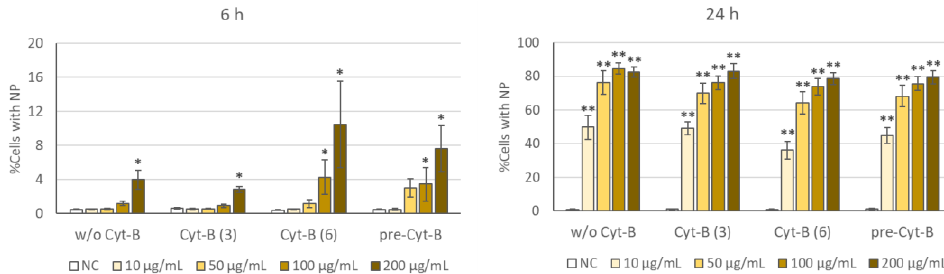
Figure 3. Cellular uptake of the TiO 2 NP at 6 h ( left ) or 24 h ( right ) treatments. Treatments were conducted in the absence of Cyt-B (w/o Cyt-B), in the presence of 3 or 6 µg/mL of this substance (Cyt-B (3) and Cyt-B (6), respectively), or in the presence of 6 µg/mL Cyt-B added 1 h before the initiation of TiO 2 NP treatment (pre-Cyt-B). Error bars represent mean standard error. * p < 0.05; ** p < 0.01, significant difference with regard to the corresponding negative control (NC). No differ- ences were observed in the comparisons between the different treatment options within the same TiO 2 NP dose and treatment time.